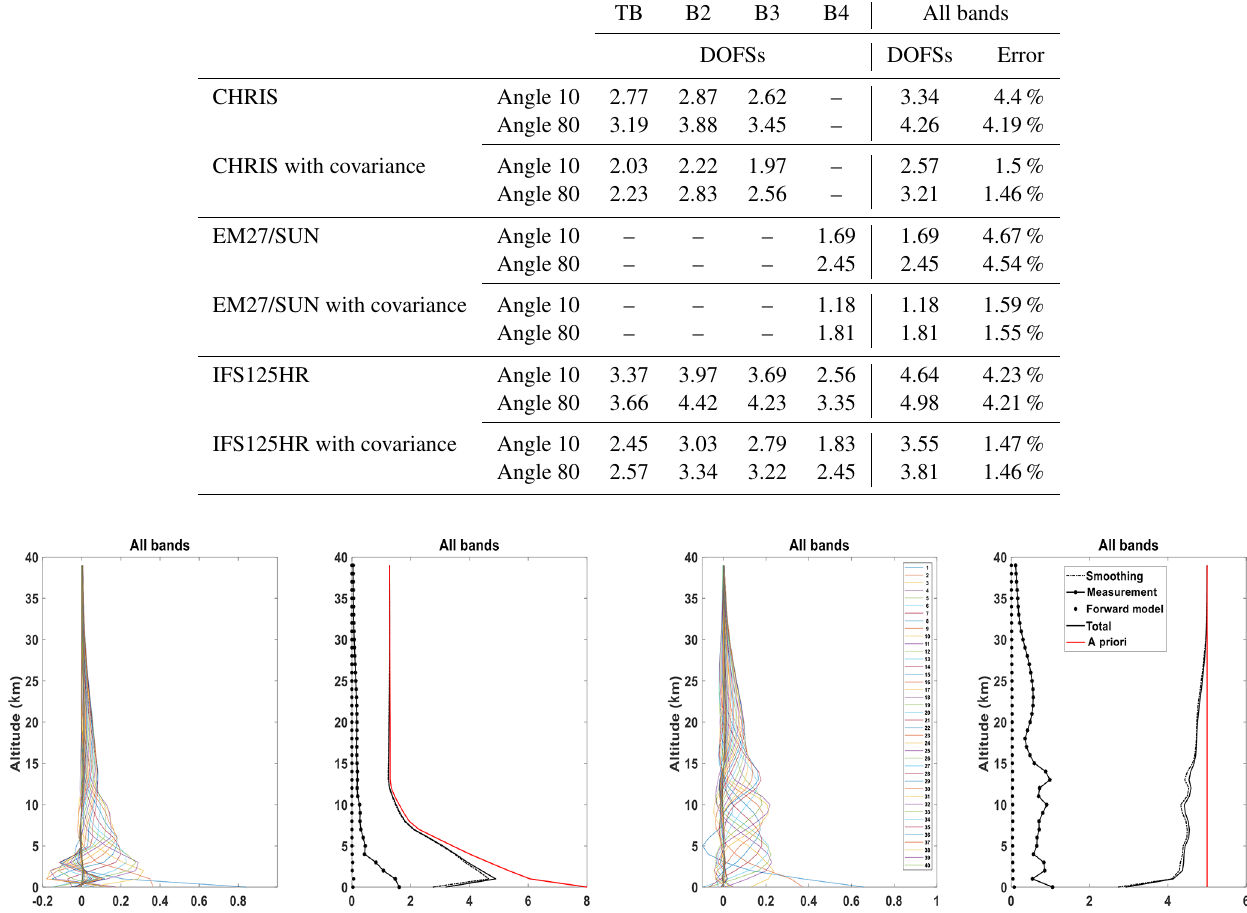
Table 5. The DOFSs and column errors (%) of CH 4 for each band and for each instrument.